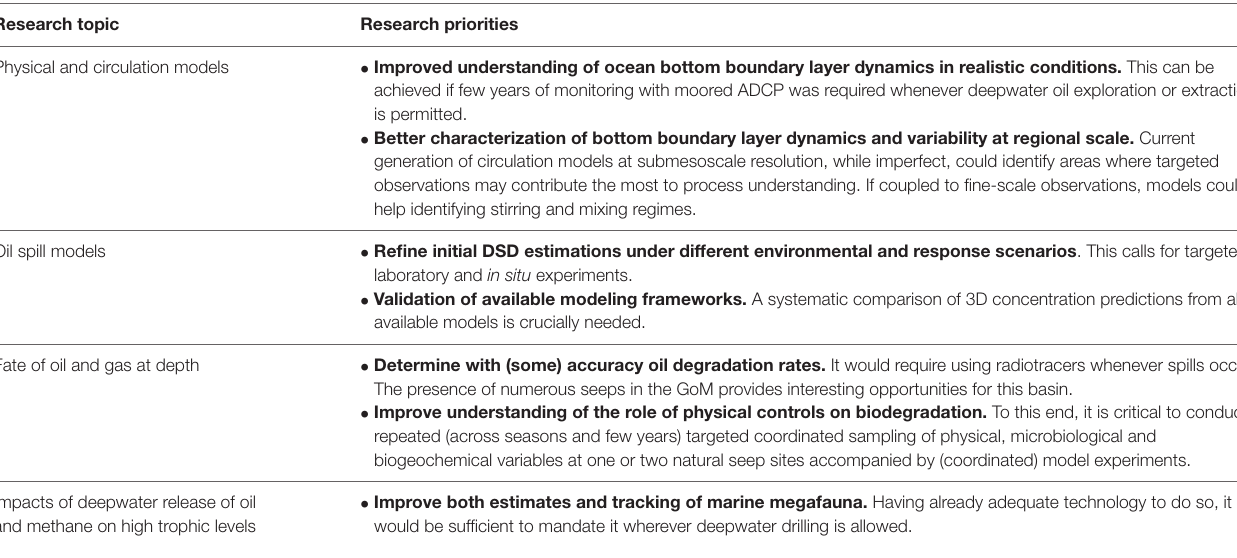
TABLE 1 | Identified research